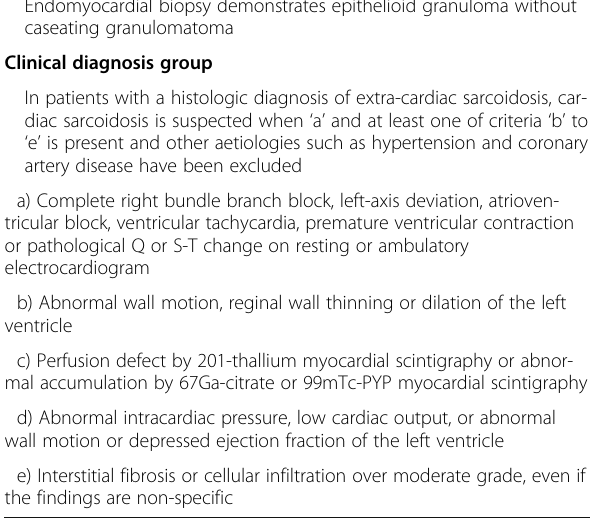
Table 1 ‘ Japan Criteria ’ for the diagnosis of cardiac sarcoidosis [15] Histologic diagnosis group Endomyocardial biopsy demonstrates epithelioid granuloma without caseating granulomatoma Clinical diagnosis group In patients with a histologic diagnosis of extra-cardiac sarcoidosis, car- diac sarcoidosis is suspected when ‘ a ’ and at least one of criteria ‘ b ’ to ‘ e ’ is present and other aetiologies such as hypertension and coronary artery disease have been excluded a) Complete right bundle branch block, left-axis deviation, atrioven- tricular block, ventricular tachycardia, premature ventricular contraction or pathological Q or S-T change on resting or ambulatory electrocardiogram b) Abnormal wall motion, reginal wall thinning or dilation of the left